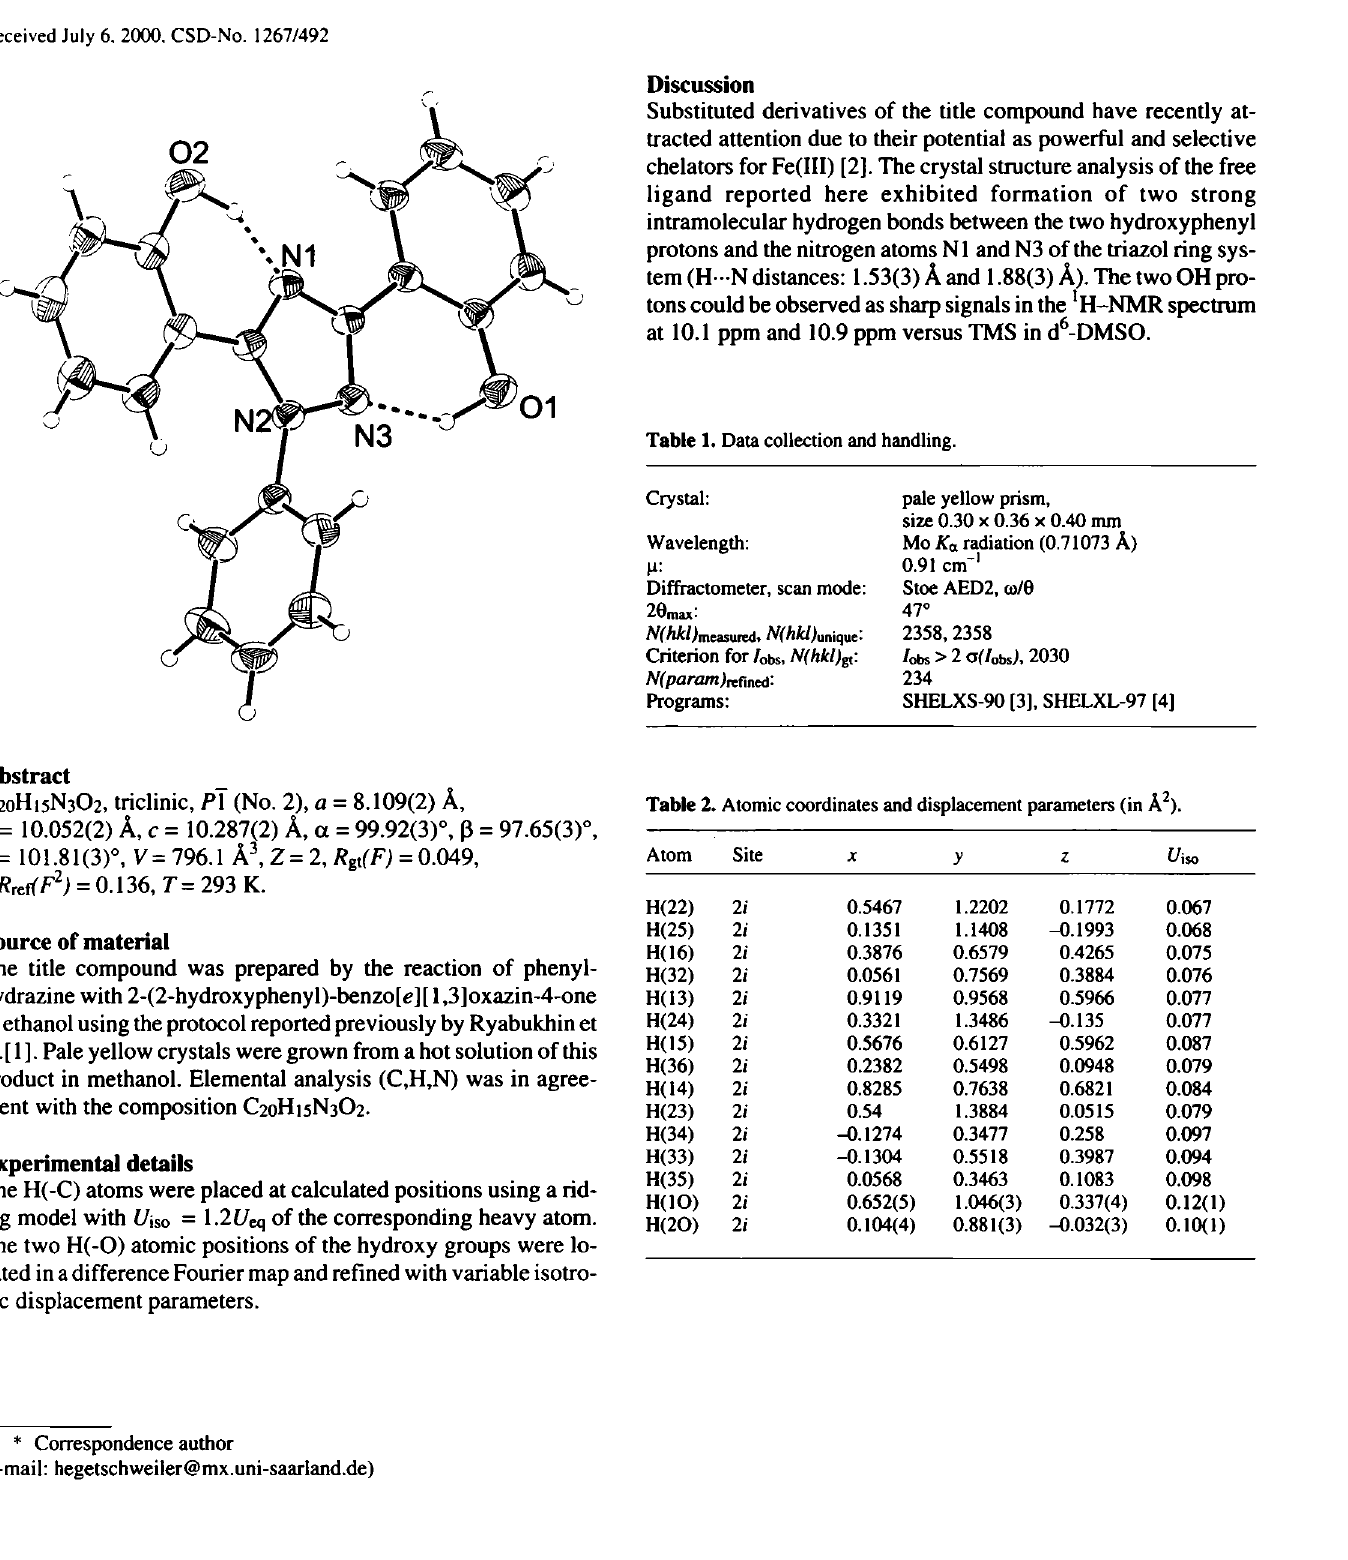
Table 1. Data collection and handling.